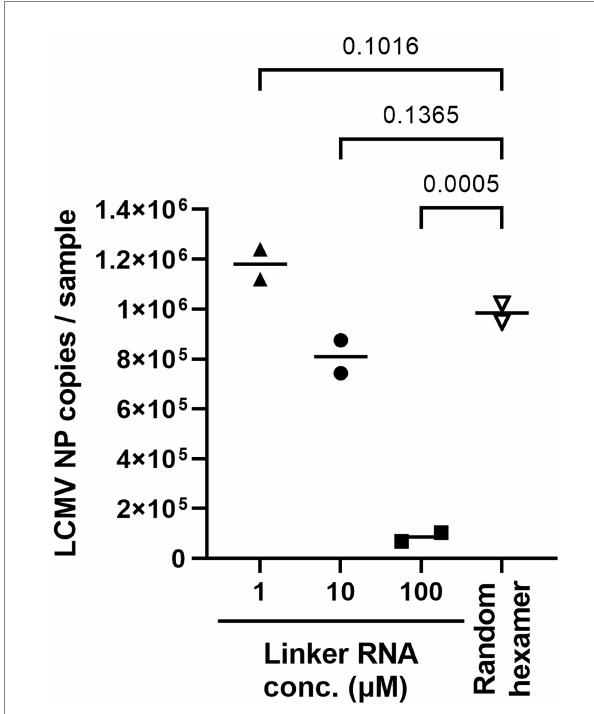
FIGURE 3 Ligation efficacy of cSP6-L at various linker concentrations. Purified RNA samples of LCMV were ligated with cSP6-L at various concentrations. First, RT was performed using SP6 primer following linker ligation. Subsequently, qPCR was performed to measure the copies of linker ligated LCMV NP cDNA in duplicate samples. Then, the same amount of purified RNA as the ligated cSP6-L was reverse- transcribed with random hexamer primers, and the copy number was measured for the experimental control. A two-way analysis of variance (ANOVA) with Dunnett’s multiple-comparison test was used to determine the level of statistical significance. The calculated value of ps are shown above the groups that were compared.